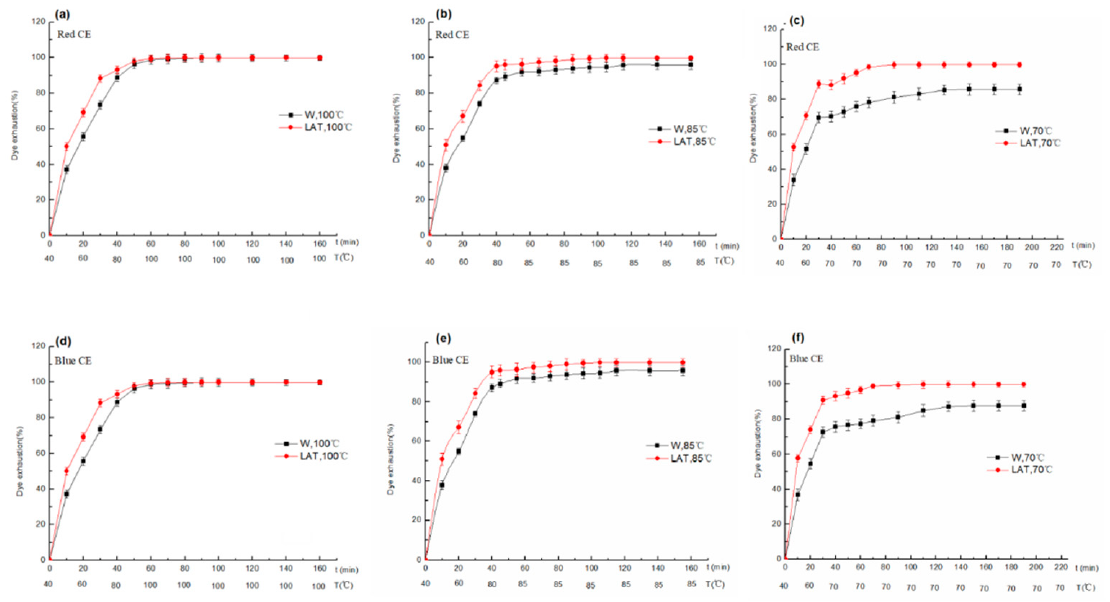
Figure 8. Dyeing rate of W and LAT dyed at different temperatures: ( a ) Red CE-100 °C; ( b ) Red CE-85 °C; ( c ) Red CE-70 °C; ( d ) Blue CE-100 °C; ( e ) Blue CE-85 °C; and ( f ) Blue CE-70 °C.